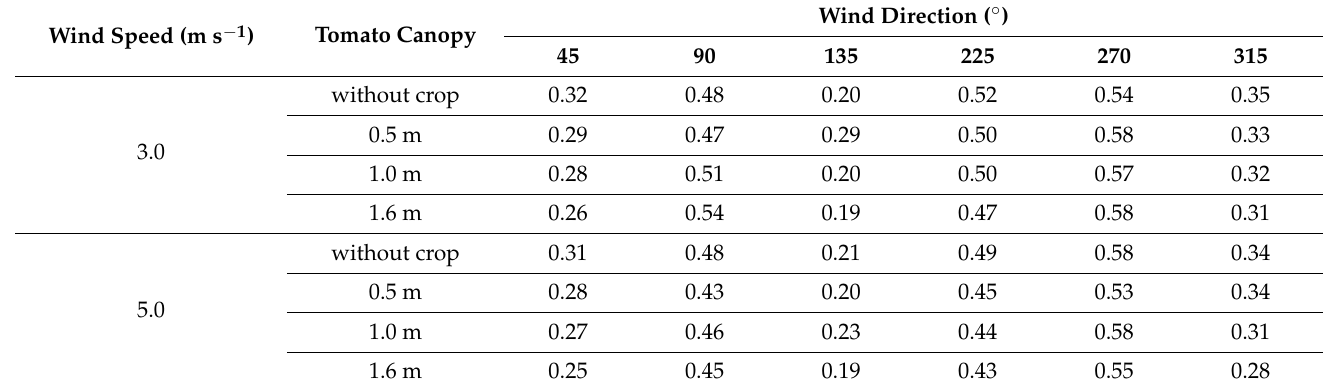
Table 8. Evaluation of C d of the greenhouse according to WD and tomato